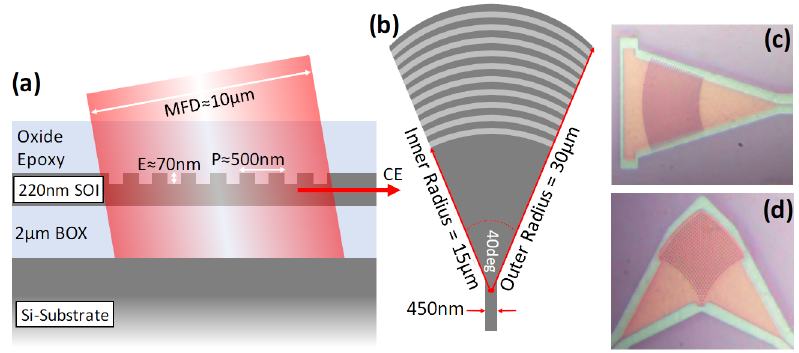
Figure 4. Fiber ‐ to ‐ PIC grating ‐ coupling; ( a ) Side ‐ view schematic of a silicon ‐ on ‐ insulator (SOI) grating ‐ coupler, with a 2 μ m bottom ‐ oxide (BOX) layer. The ≈ 10 μ m MFD (mode ‐ field diameter) fiber ‐ mode is incident on the grating ‐ coupler with a ≈ 10° angle ‐ of ‐ incidence; ( b ) Top ‐ view schematic of a 1D focusing grating ‐ coupler. The footprint of the coupler matches the MFD of the fiber ‐ mode; ( c , d ) Microscope images of one ‐ dimensional (1D) and two ‐ dimensional (2D) grating ‐ couplers, respectively.